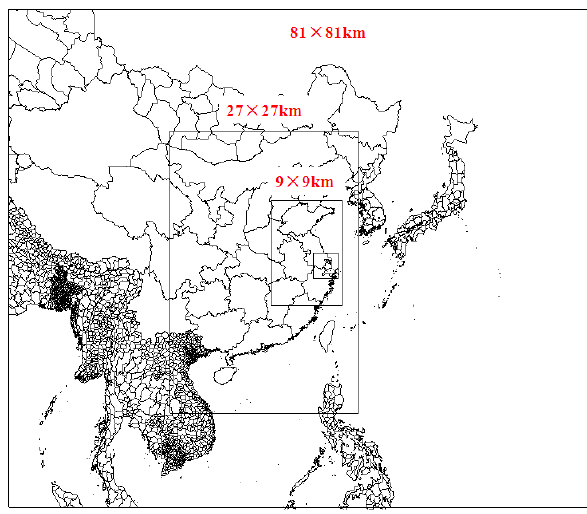
Fig.1. One-way nested CMAQ model domain Fig. 1. One-way nested CMAQ model